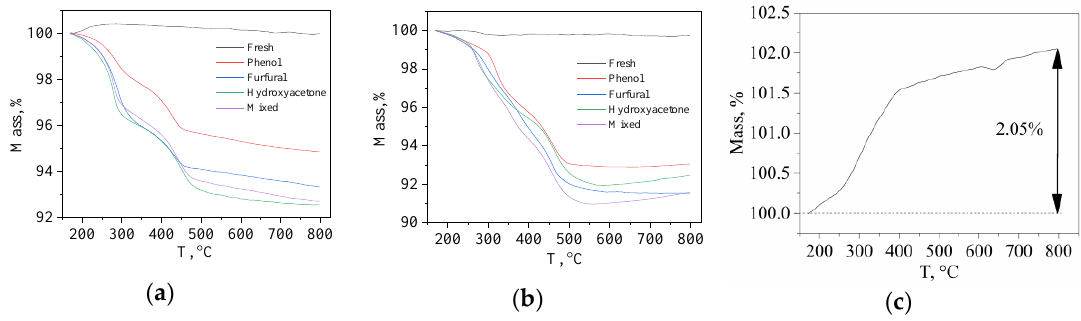
Figure 12. Thermogravimetric analysis (TGA) curves of the reduced and used catalyst in ( a ) air and ( b ) N 2 atmosphere, and ( c ) reduced catalyst in air after TGA analysis in N 2 . Table 4. TGA results of the reduced and used catalyst.